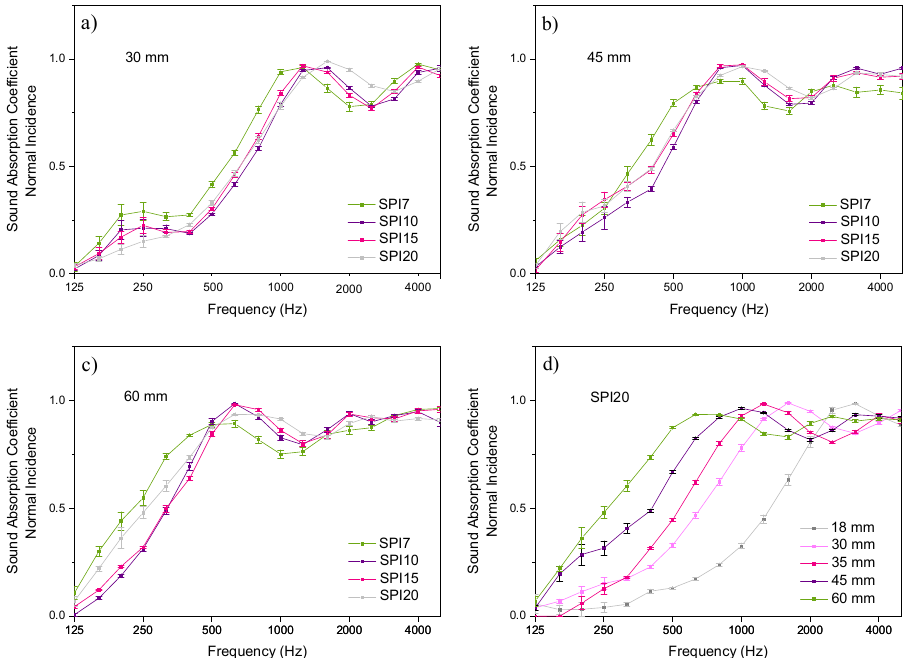
Figure 3. Sound absorption coefficients at normal incidence for SPI7, SPI10, SPI15, and SPI20 samples that were ( a ) 30, ( b ) 45, and ( c ) 60 mm thick. ( d ) Sound absorption coefficient at normal incidence for SPI20 sample as a function of thickness (18, 30, 35, 45, and 60 mm).